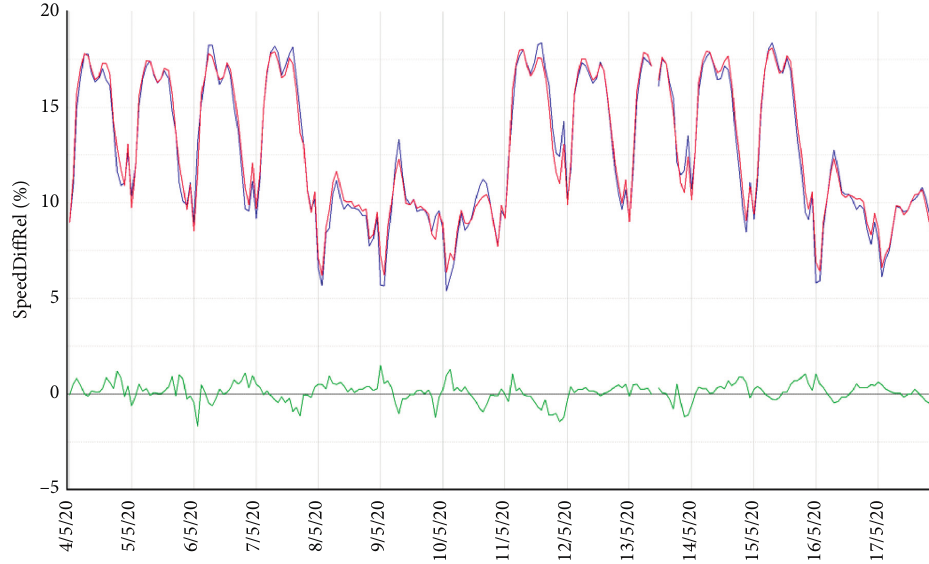
Figure 13: Two-week period from 4 April to 17 May 2020. SpeedDiffRel in percentage points by